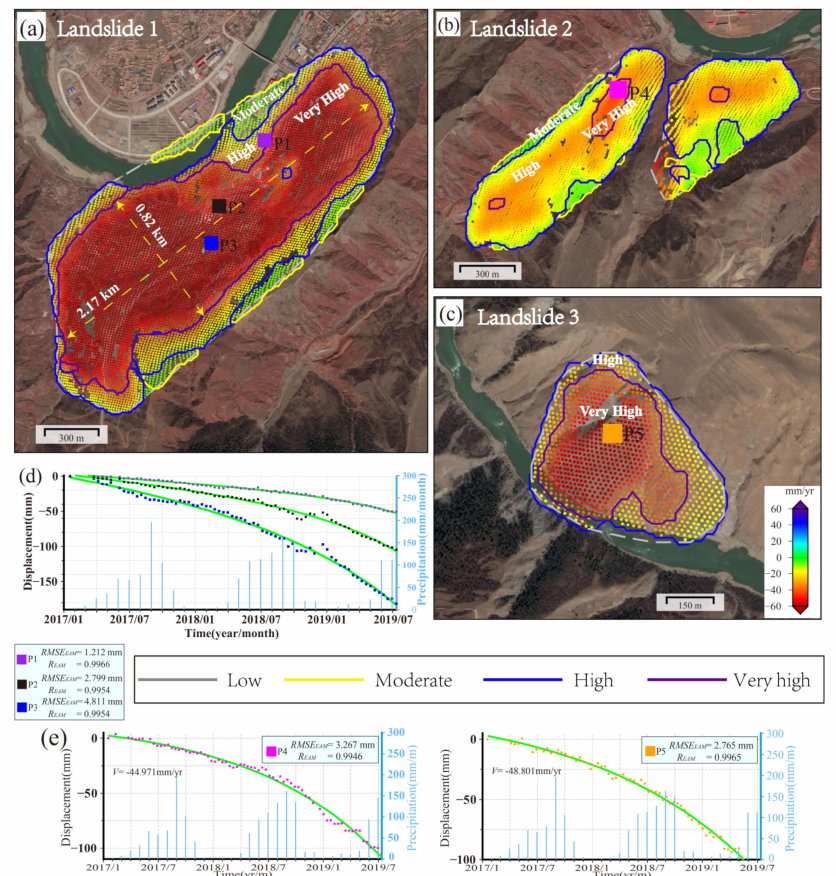
Figure 10. Some very high-instability level areas in Lajia Town. ( a – c ) are the maps of the deformation velocity, and instability refinement of the points in the area outlined by blue, purple, and brown dashed lines in Figure 9a, respectively. ( d , e ) the time series of P1~P5 points. The green curve is the EAM curve after